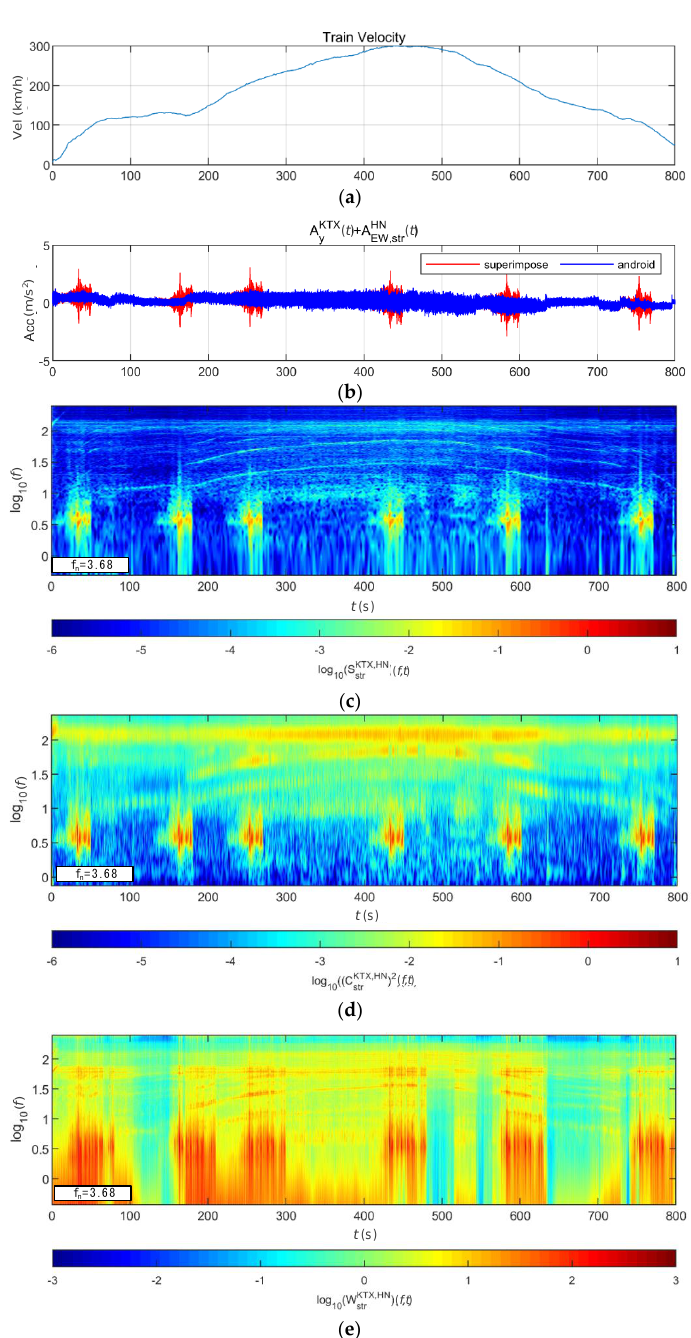
Figure 38. Combination of train data with BR3 bridge-response data from the Hachinohe earthquake (scaled to 1000-year return period): ( a ) velocity; ( b ) lateral acceleration time series; ( c ) STFT; ( d ) WT; ( e ) WVD.